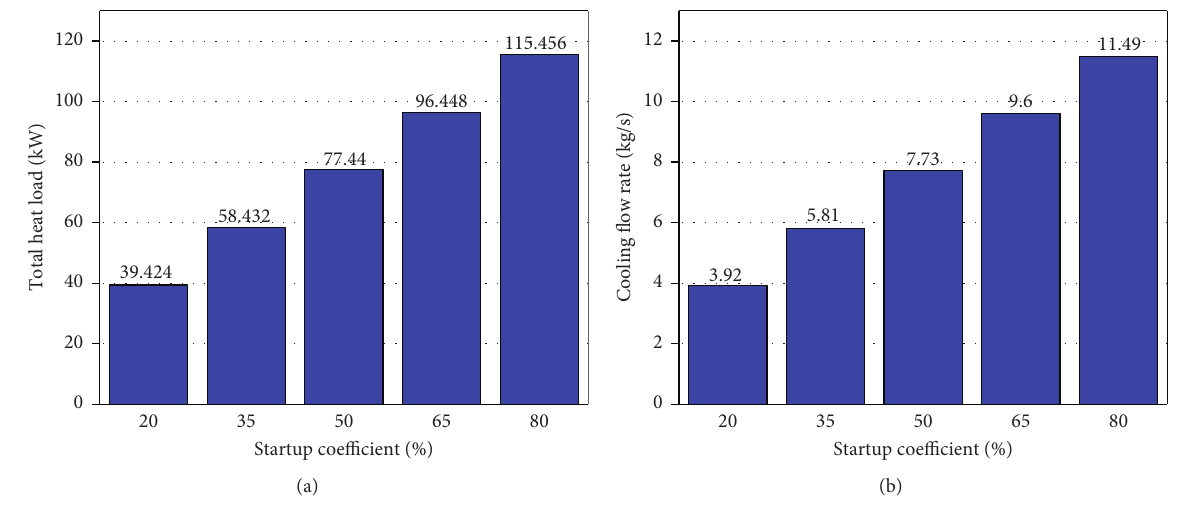
Figure 2: Total heat load (a) and cooling flow rate (b) of the DC.